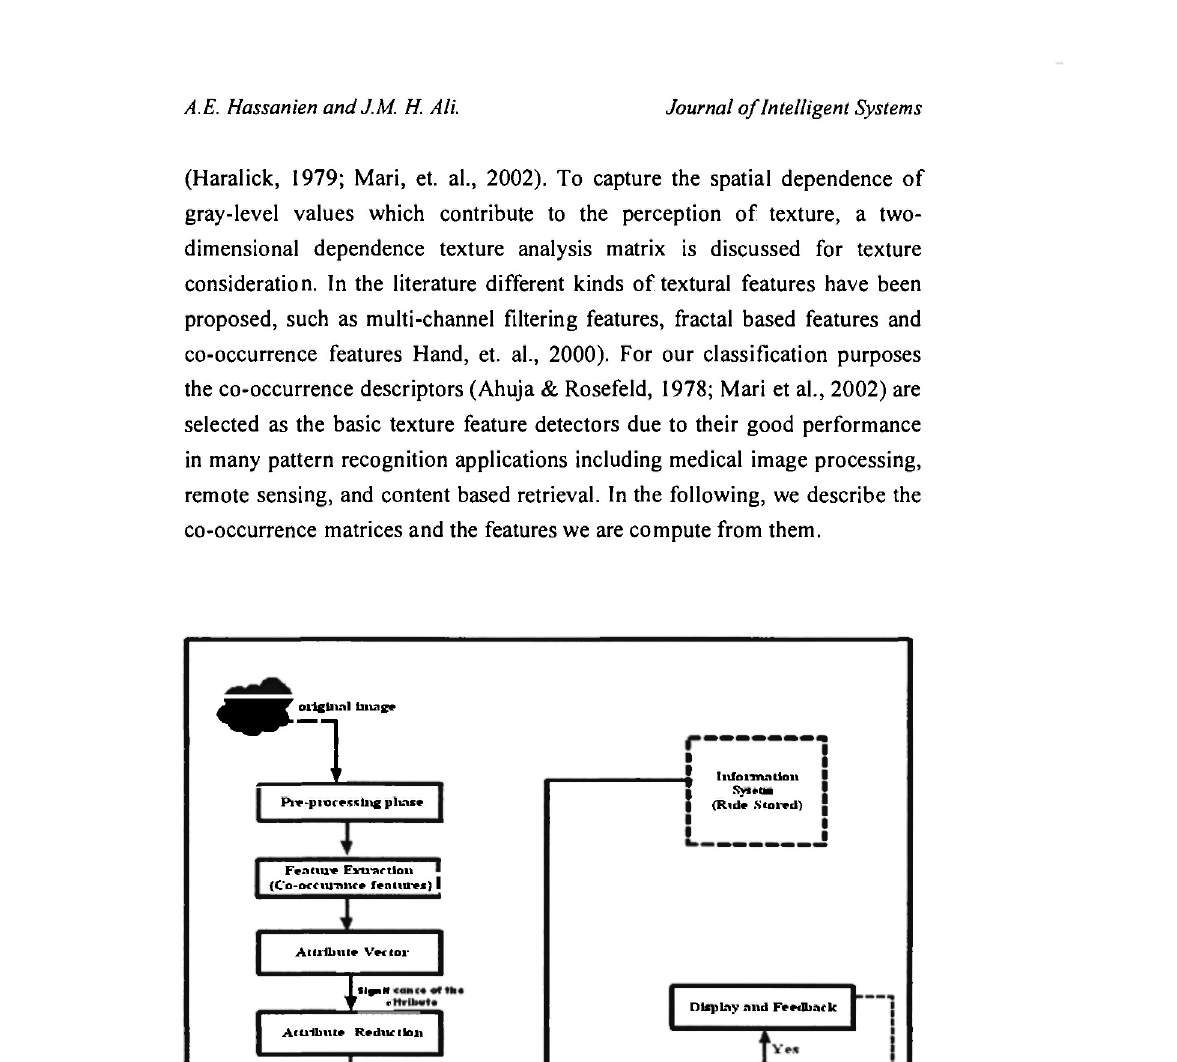
Fig. 2: Image classification architecture under the rough set